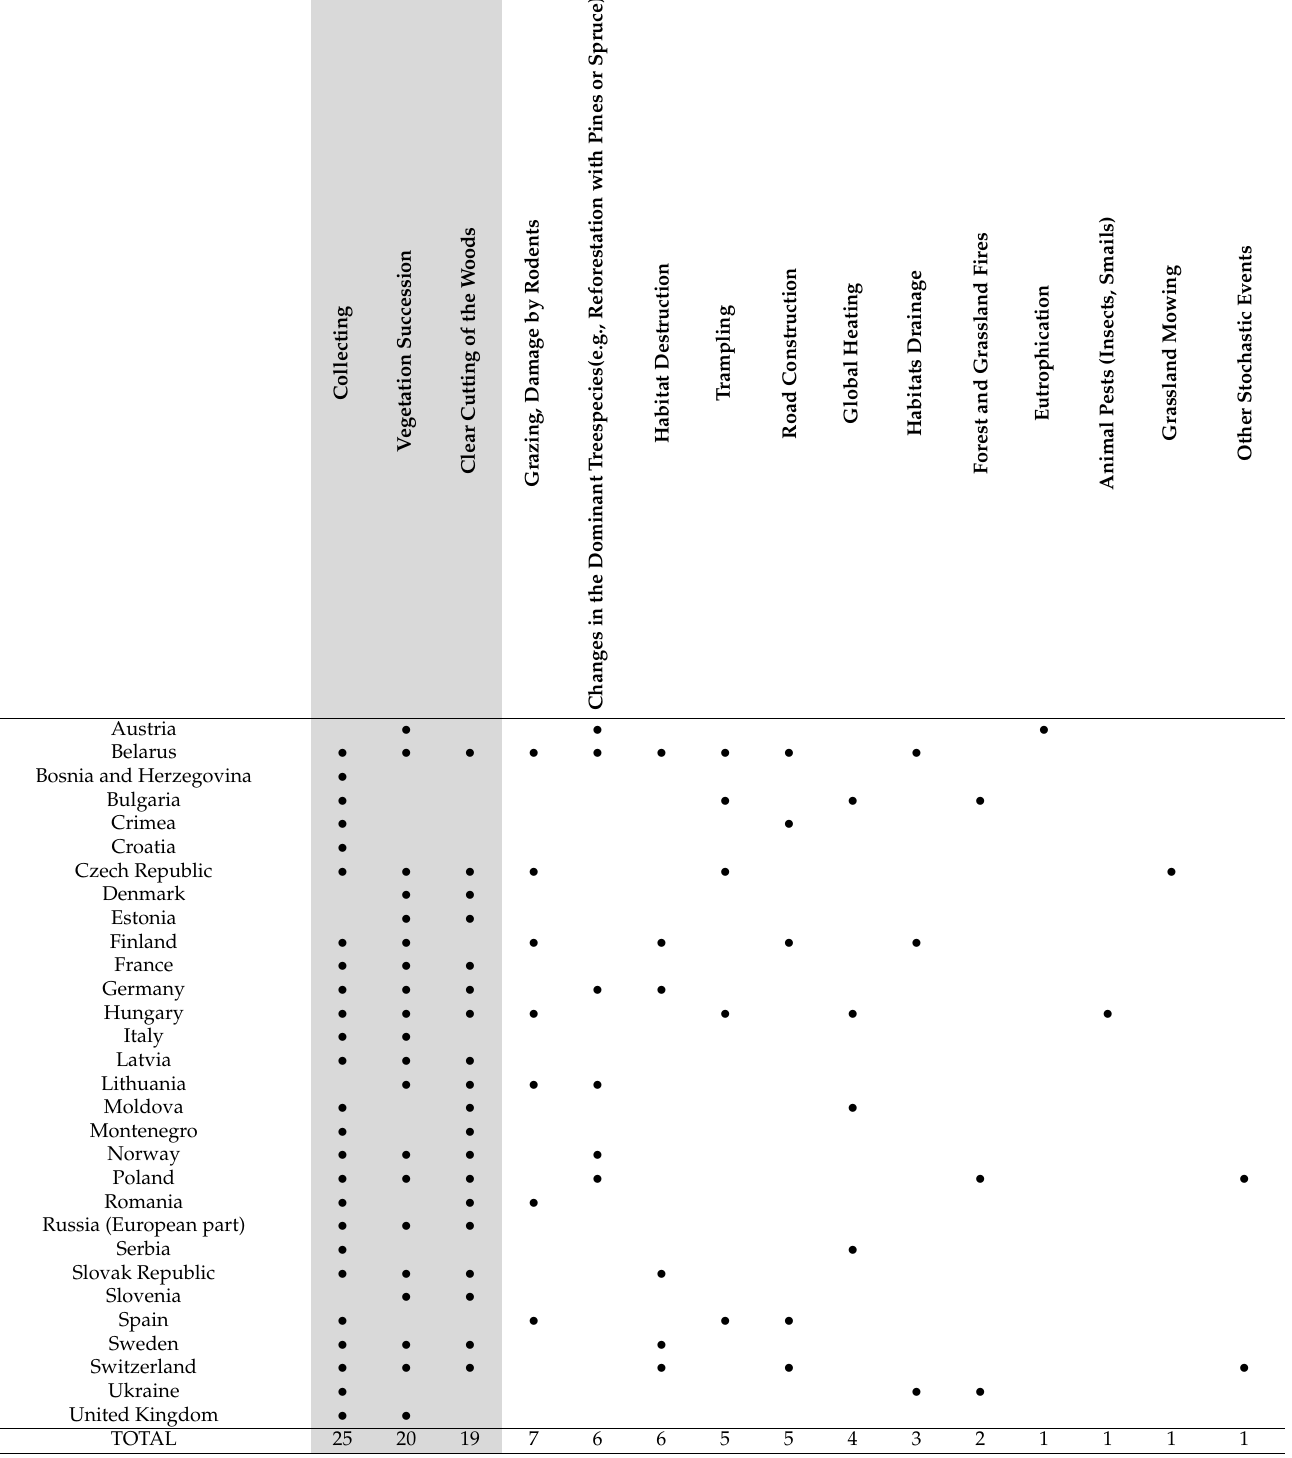
Table 2. Factors that have been identified as threats for Cypripedium calceolus, by